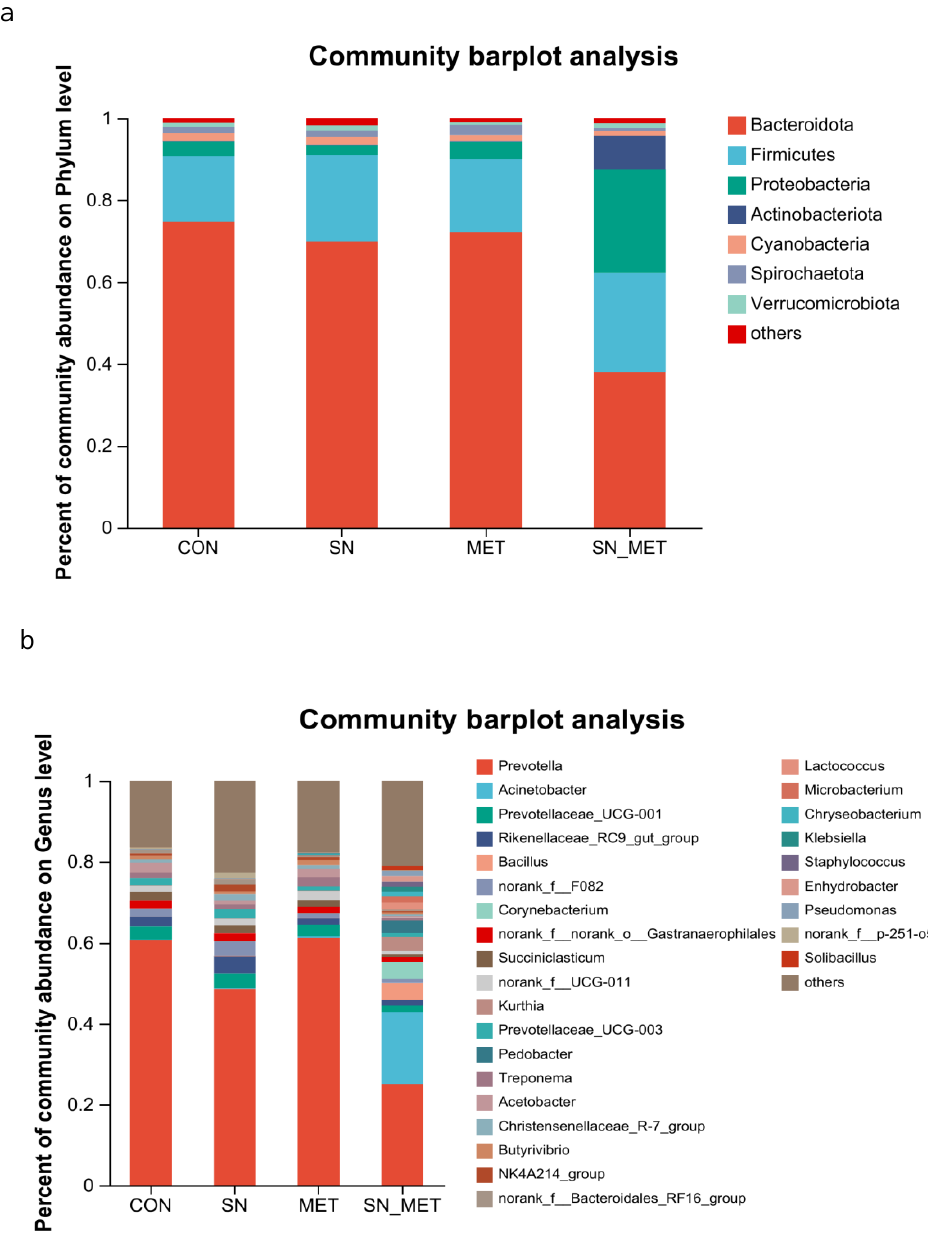
Figure 3. Relative abundance of rumen microflora of buffalo at the phylum level ( a ) and genus level ( b ) in the control (CON), 70 g/d sodium nitrate (SN), 15 g/d L-methionine (MET), and sodium nitrate group 70 g/d + L-methionine 15 g/d (SN+MET) groups.